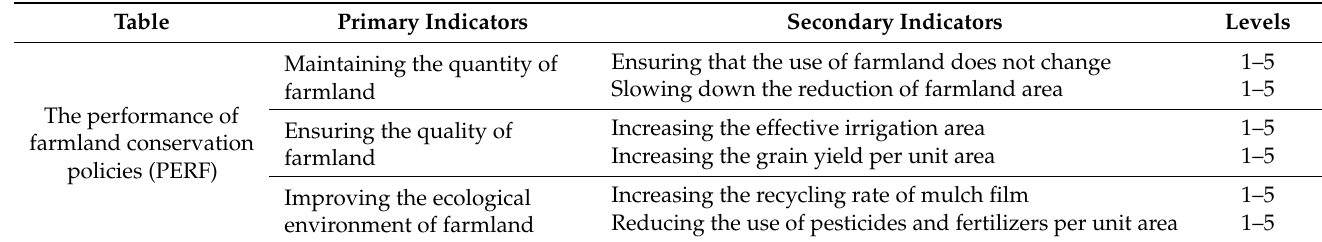
Table 3. Farmland conservation performance evaluation index system.